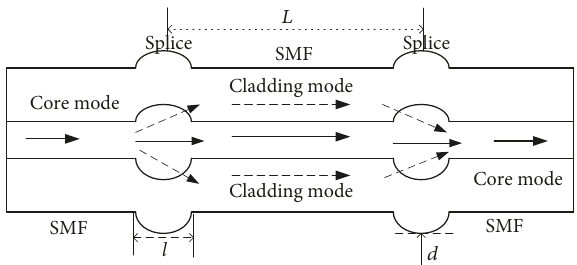
Figure 1: The schematic of a proposed humidity sensor structure; the inset shows the image of the MC material.